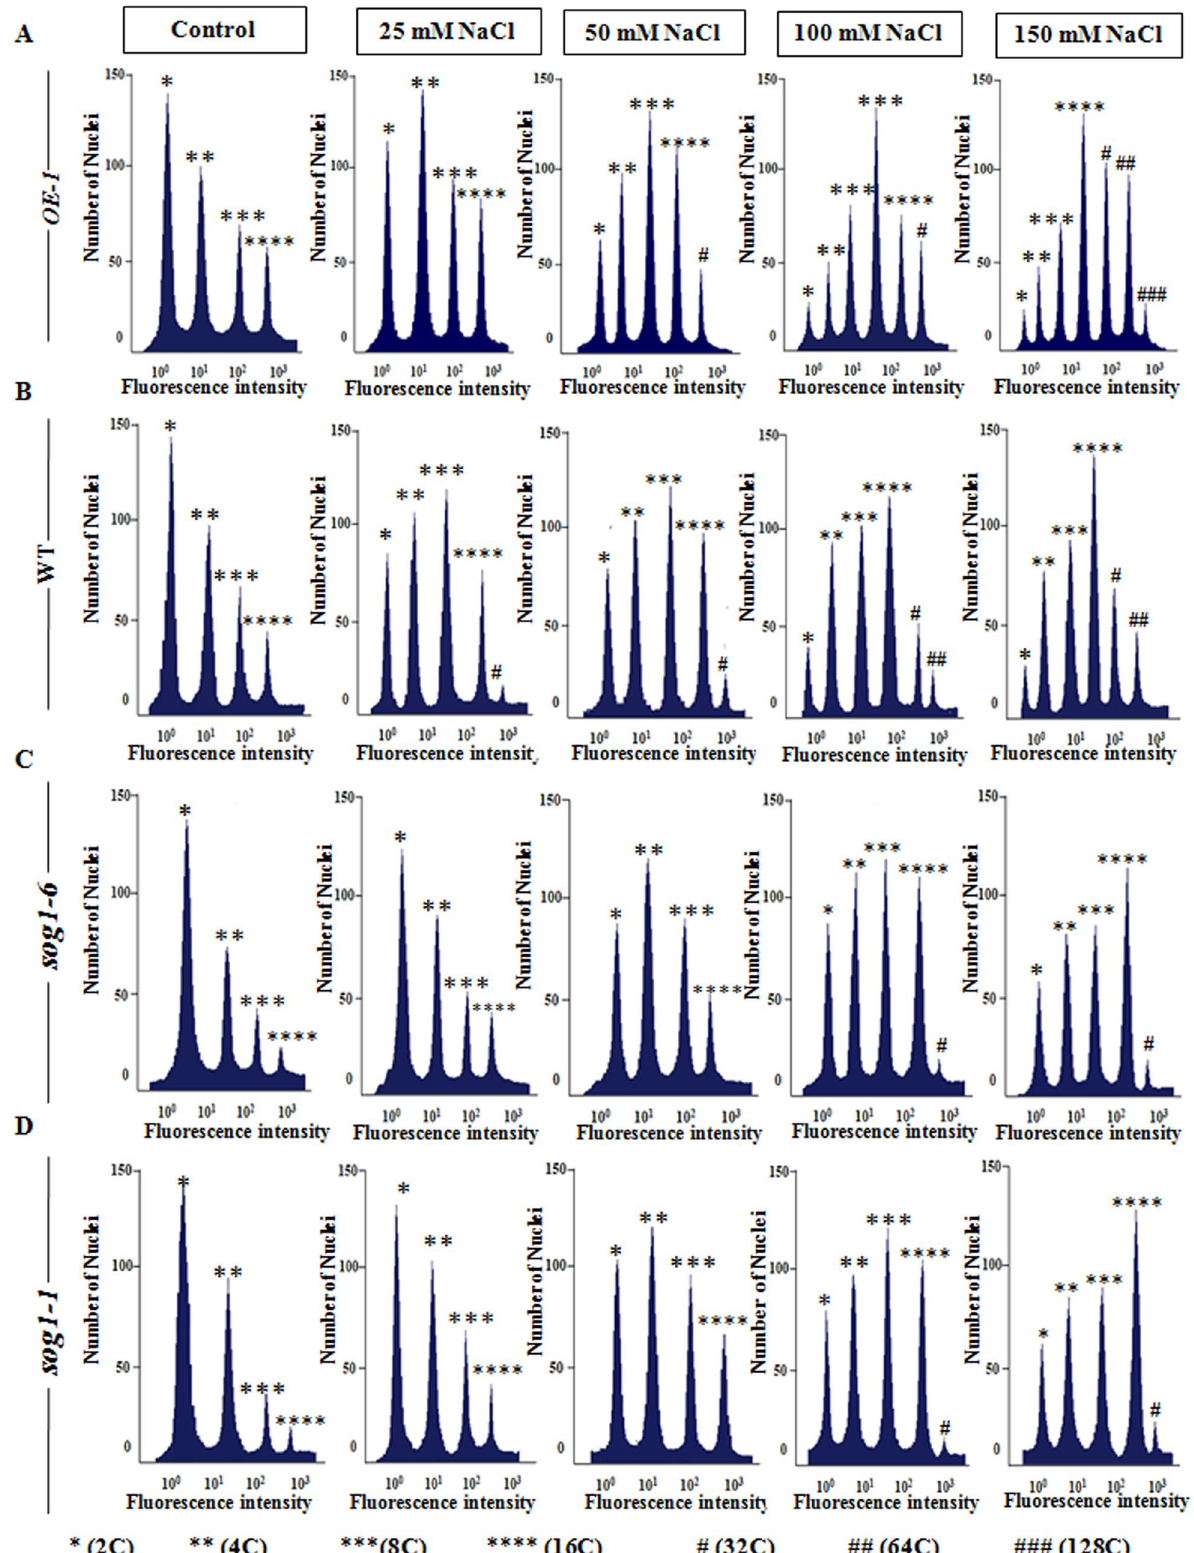
Figure 4. Salinity induced endoreduplication in the root cells. ( A – D ) Flowcytometric analysis of ploidy level in the DAPI-stained root cell nuclei of 7-days old OE-1 , wild-type, sog1-6 and sog1-1 mutant plants treated without or with increasing concentrations of NaCl. A total of 10,000 events were recorded for each run and the data were analysed by FlowJo v. 10.0.6 (Tree Star, Inc.) software. All flow cytometric analyses were repeated with at least three independent biological replicates and representative ploidy distributions of total nuclei are given at the top of each